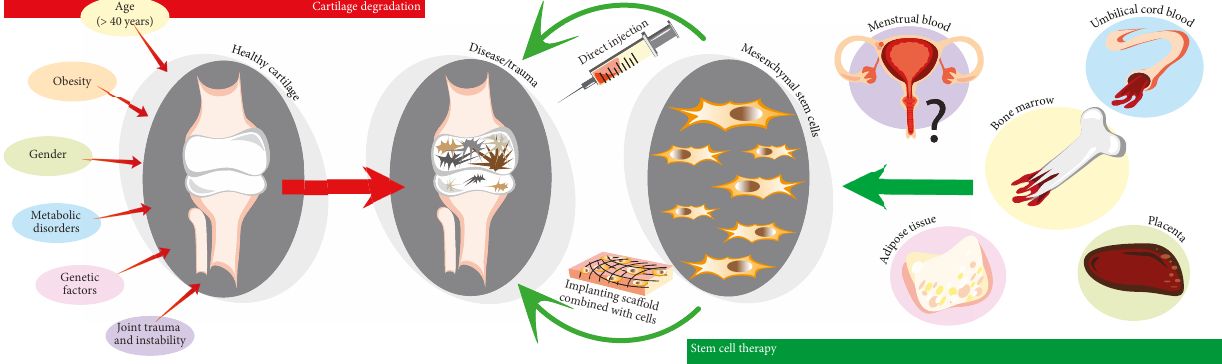
Figure 2: Major OA risk factor strategies for promoting cell-based cartilage